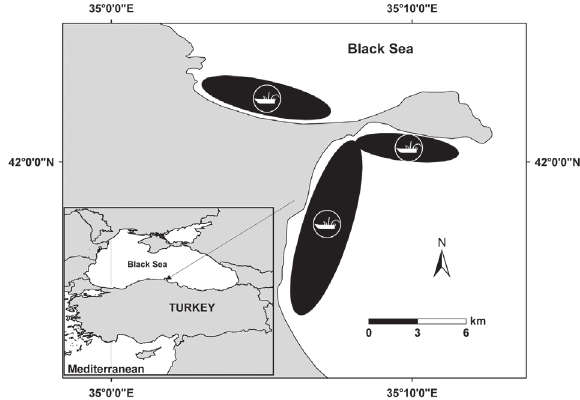
Fig . 1. – Sampling sites (shaded areas) in the Sinop Peninsula, Black